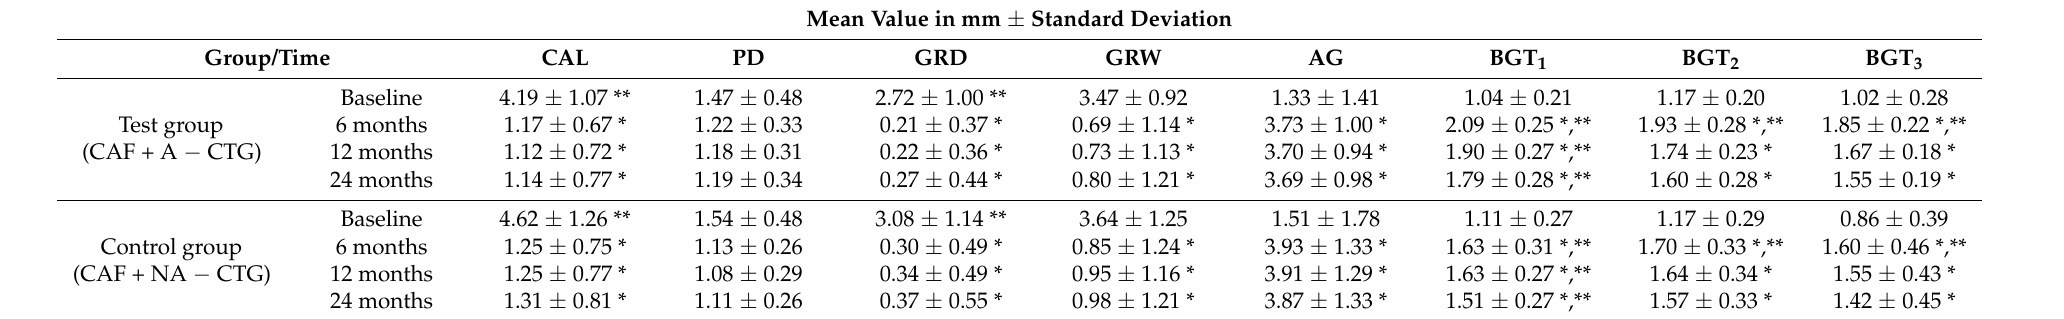
Table 2. Clinical parameters at baseline, 6, 12 and 24 months after intervention.